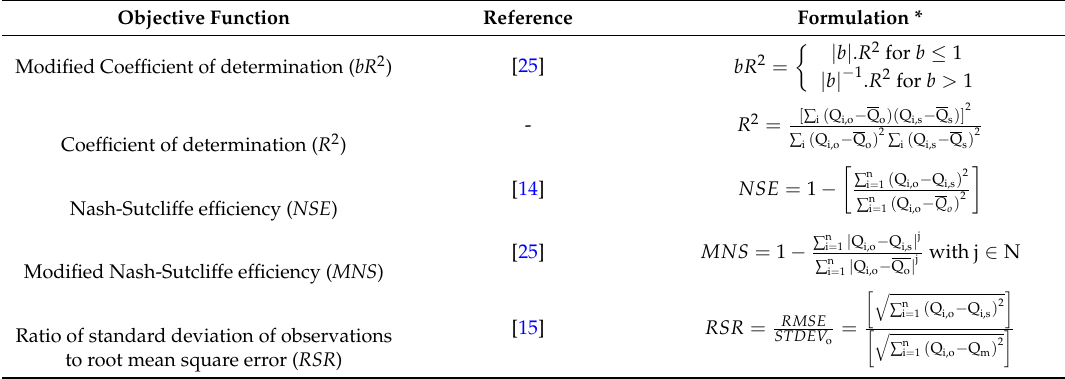
Table 1. Formulation of the objective